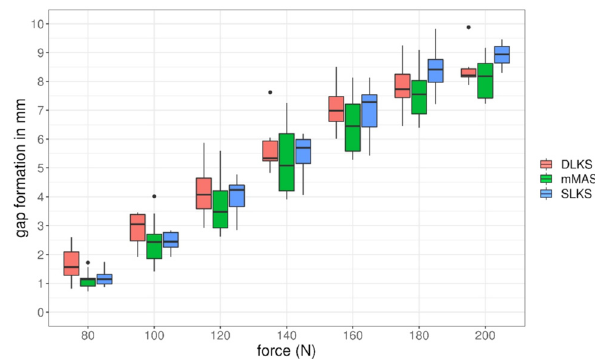
Figure 4: Gap formation in cyclic loading ( 10 to 80 – 200 N ) of the three types of stitches: DLKS ( brown ) , SLKS ( blue ) , and mMAS ( green )